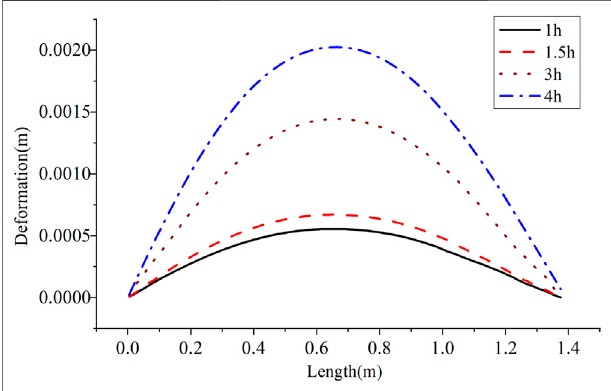
FIGURE 11 | Shape reconstructed by the 0 o ’ clock